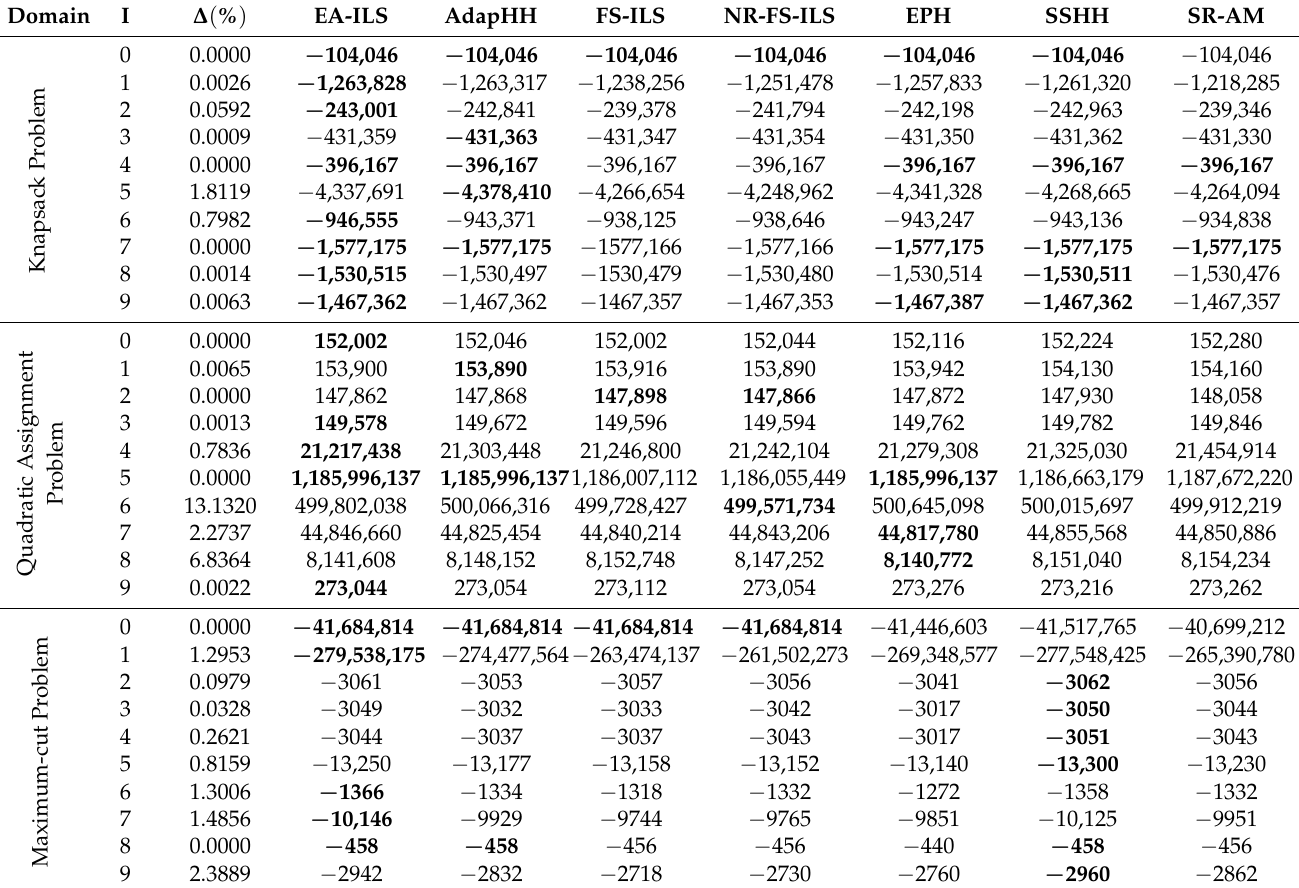
Table 3. Best ofvs Obtained by the EA-ILS in Comparison to the Existing